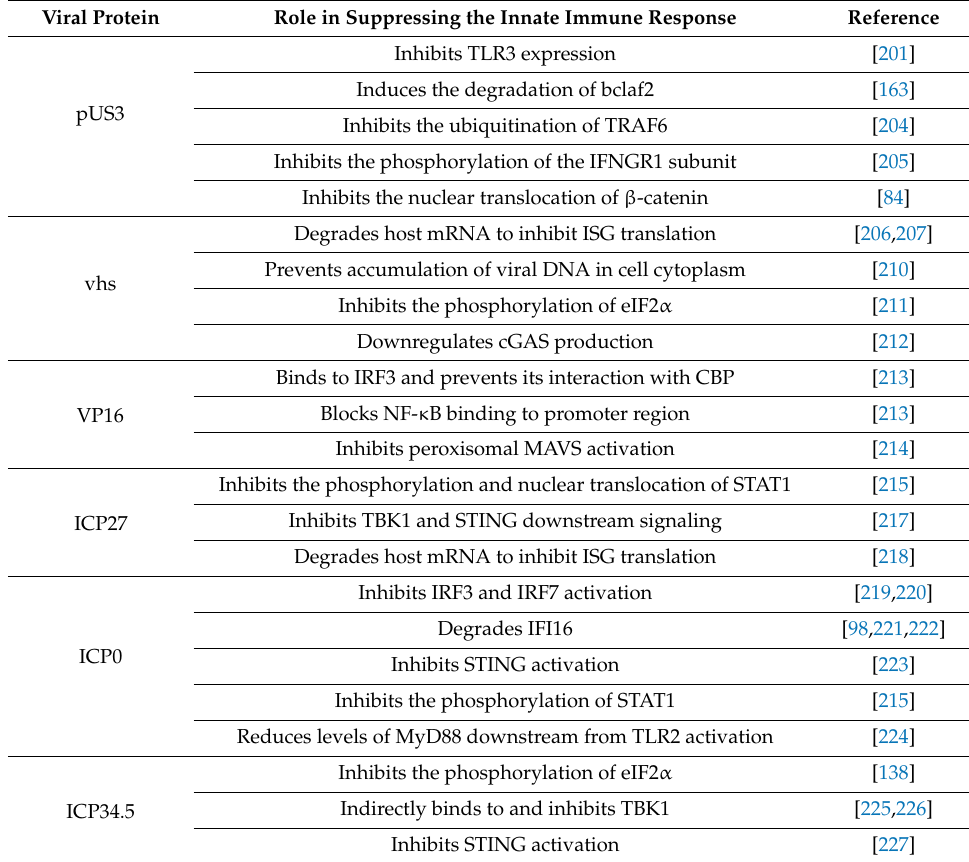
Table 2. Major viral proteins involved in immune